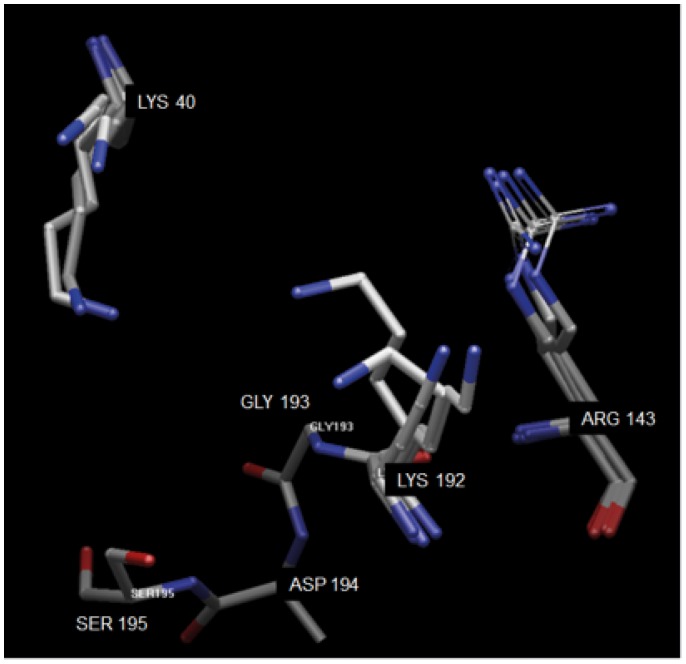
Visualization of the different positions of Lys40, Arg143 and Lys192 found in X-ray structures.The flexibility of the basic residues can be explained by crystal packing and the differences between the inhibitors used. X-rays structures included have the following PDB codes: 2HVX, 3S0N, 1T31, 3N7O.